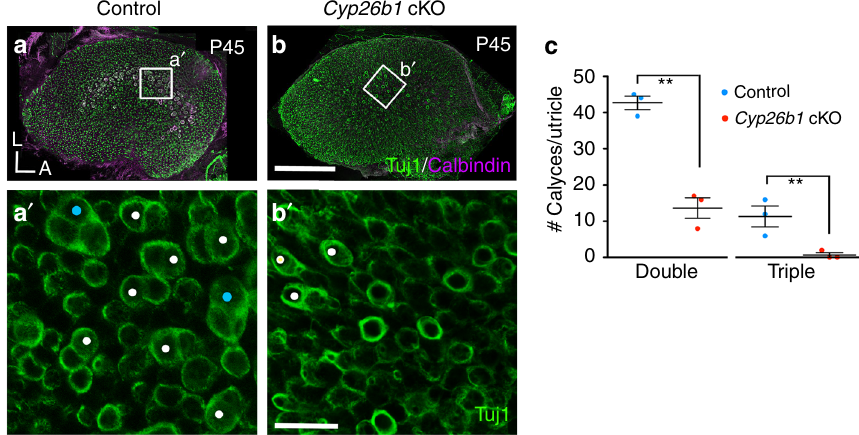
Fig. 4 Pure/complex calyces are reduced in Cyp26b1 cKO mice. a – c P45 whole-mount utricles from controls ( a , a ′ ) and Cyp26b1 cKO ( b , b ′ ) immunolabeled with anti-Tuj1 (green) and anti-calbindin (magenta) antibodies. a , b Maximum intensity projection of the entire utricle. a ′ , c Enlarged, single plane image of the rectangular region in control striola ( a ), showing the presence of large number of double (white circles, 42.6 ± 1.8 double calyces/ utricle) and triple (cyan circles, 10.0 ± 2.0 triple/utricle, n = 3 utricles) calyces at the cell body level. b ′ , c Fewer double calyces (white circles, 13.6 ± 2.8 double calyces/utricle, P = 0.001, unpaired t test) and no triple calyx (0.6 ± 0.6 triple calyces/utricle, P = 0.006, n = 3) are found in the corresponding region of Cyp26b1 cKO mutants. Scale bars: 200 μ m for a , b ; 30 μ m for a ′ , b ′ . ** P < 0.01. A, anterior; L, lateral. Error bars: